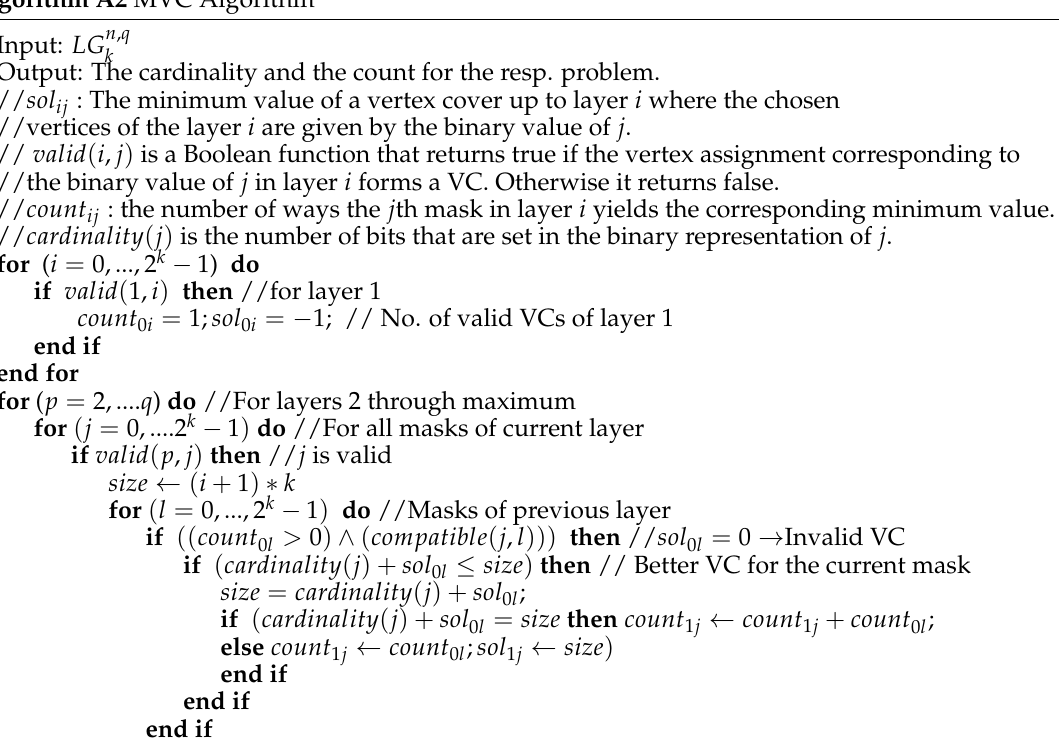
Algorithm A2 MVC